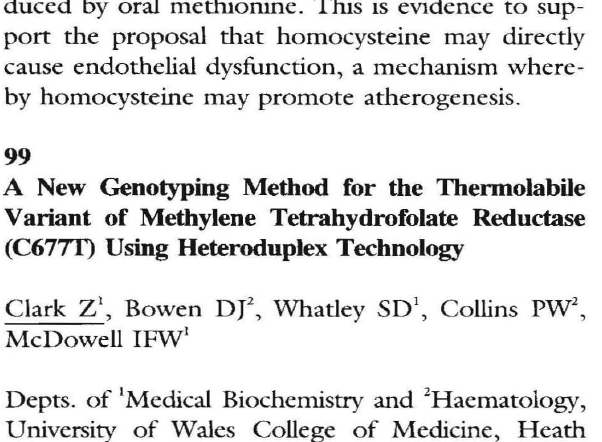
patients with angina were